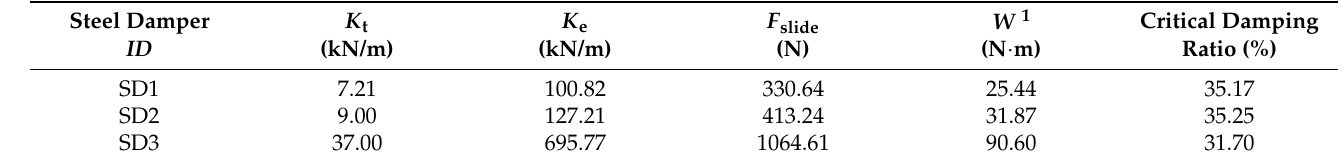
Table 11. Evaluation results of energy dissipation capacity of steel dampers.